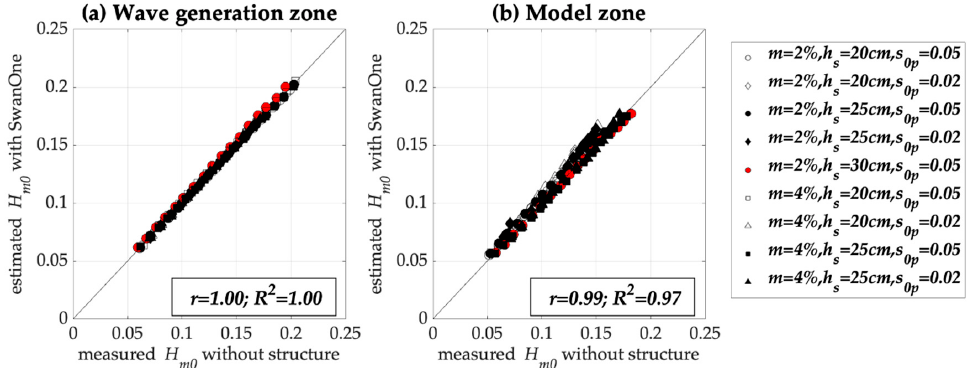
Figure 4. The measured spectral wave height without a structure (total waves) compared to the incident spectral wave height estimated by the SwanOne model: ( a ) in the wave generation zone, and ( b ) in the model zone. Two statistics were used in this study to quantify the goodness of fit: (1) the correla- tion coefficient ( r ), and (2) the coefficient of determination ( R 2 ). 0 ≤ r ≤ 1 assessed the cor- relation, and 0 ≤ R 2 ≤ 1 estimates the proportion of variance explained by the model. There- fore, the higher the r and the higher the R 2 , the better.